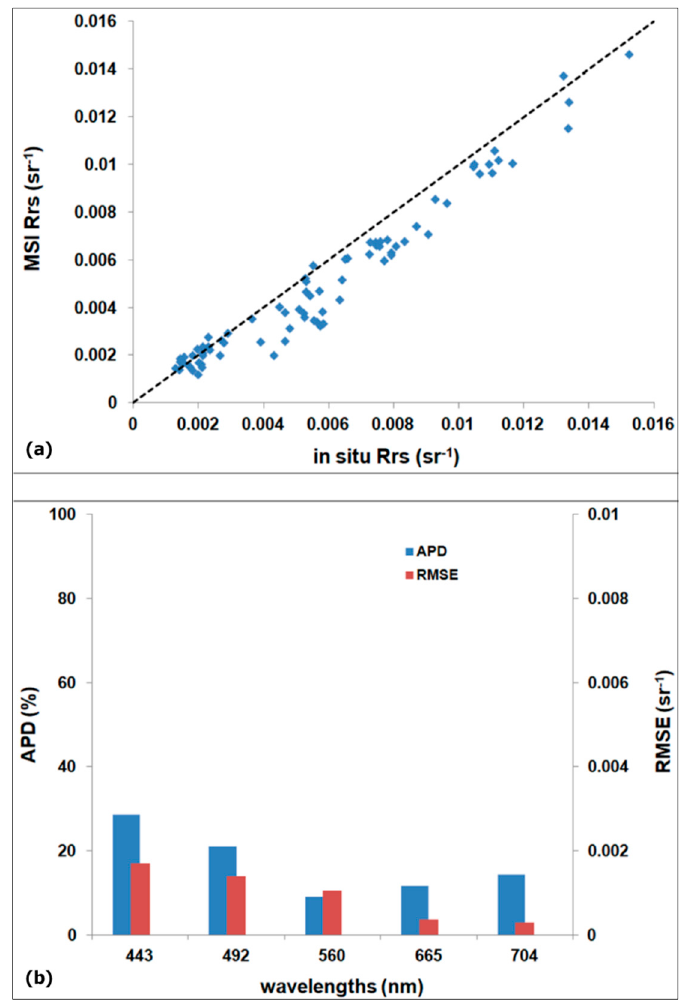
Figure 5. ( a ) Scatter plot of in situ versus MSI-S2A derived Rrs ( λ ) values for the 443–704 nm spectral range. In the plot, the dashed line is the 1:1 line. ( b ) Histogram of error indicators (APD and RMSE)